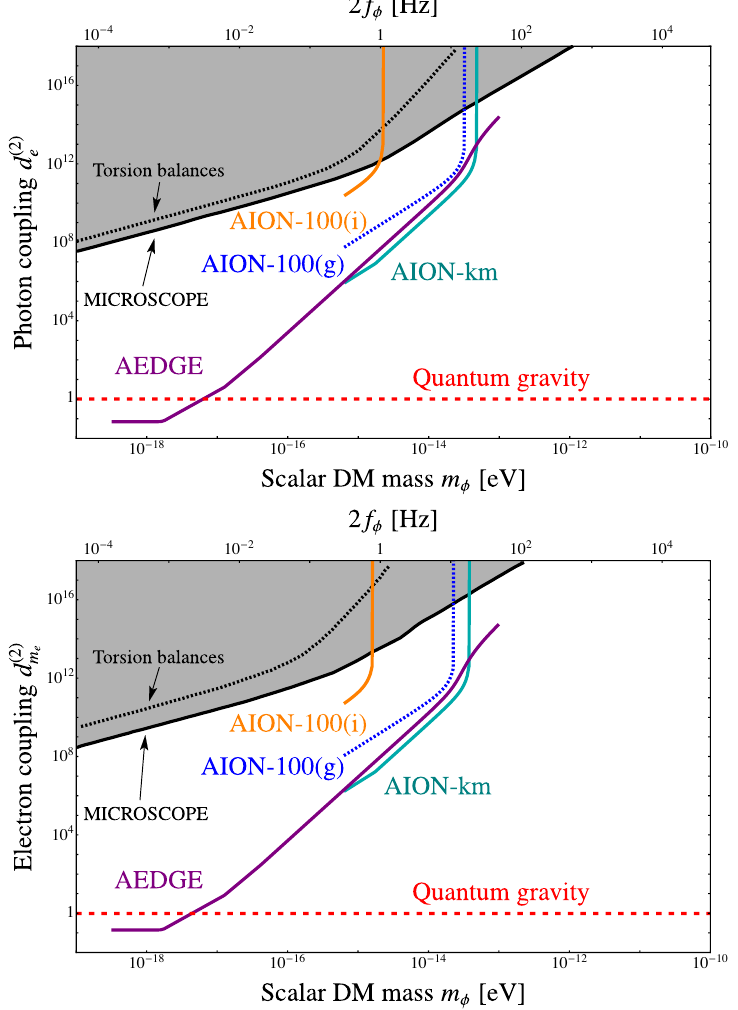
( 2 ) ( 2 ) ( 2 ) ( 2 ) Figure 3. Bounds on the parameters d , d as a function of the mass of the scalar field. Quantum e , d m e as a function of the mass of the scalar field. e m e ( 2 ) ( 2 ) , d 1. AEDGE could detect a quantum-gravitational interaction of scalar e m e ∼ 5 10 − 17 eV. ∼ ×